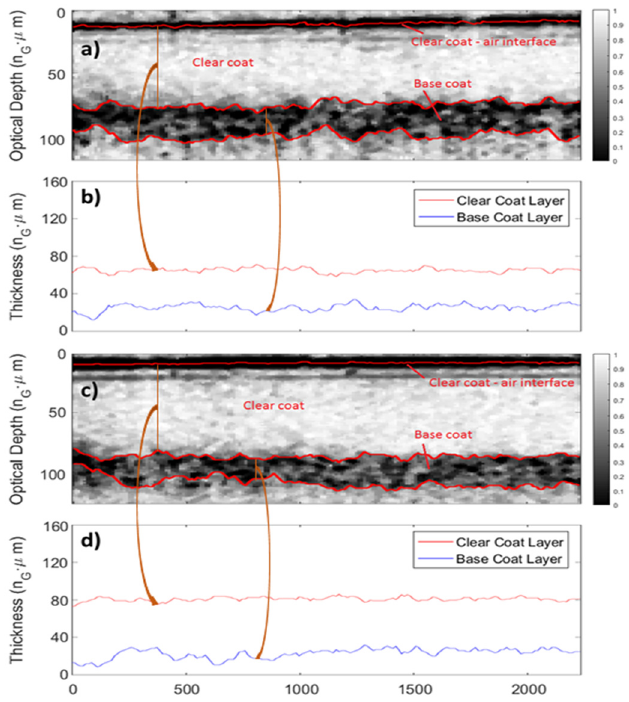
Figure 6. Final segmentation results of the silver ( a ) and blue ( c ) paint samples. The respective thickness profiles of each sample ( b , d ) as demonstrated by the brown arrows. Although they do look non-smooth, it should be noted that the thickness profile figures are presented at an aspect ratio of approximately 1:3. Table 2. Thickness measurements (mean ± standard deviation) of the base coat and clear coat layers of the paint samples scanned using full field time domain (FF) and line field spectral domain (LF) OCT.